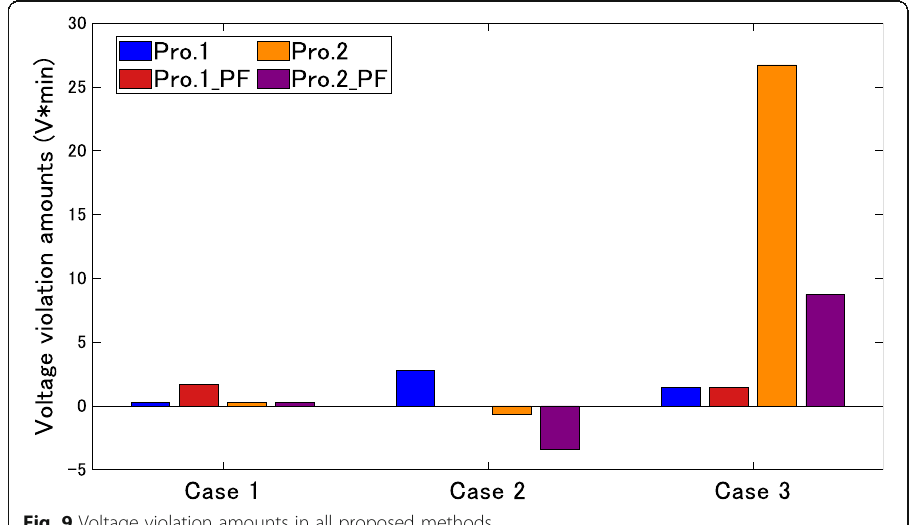
Fig. 9 Voltage violation amounts in all proposed